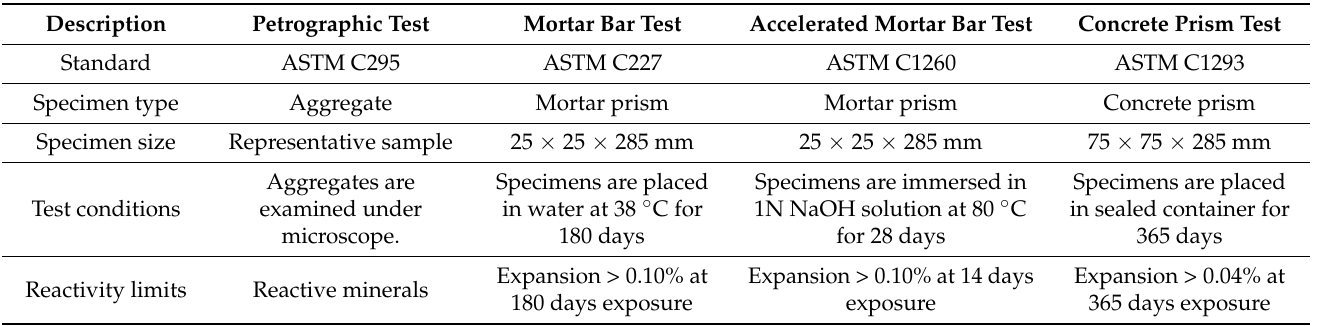
Table 1. Test methods for assessing